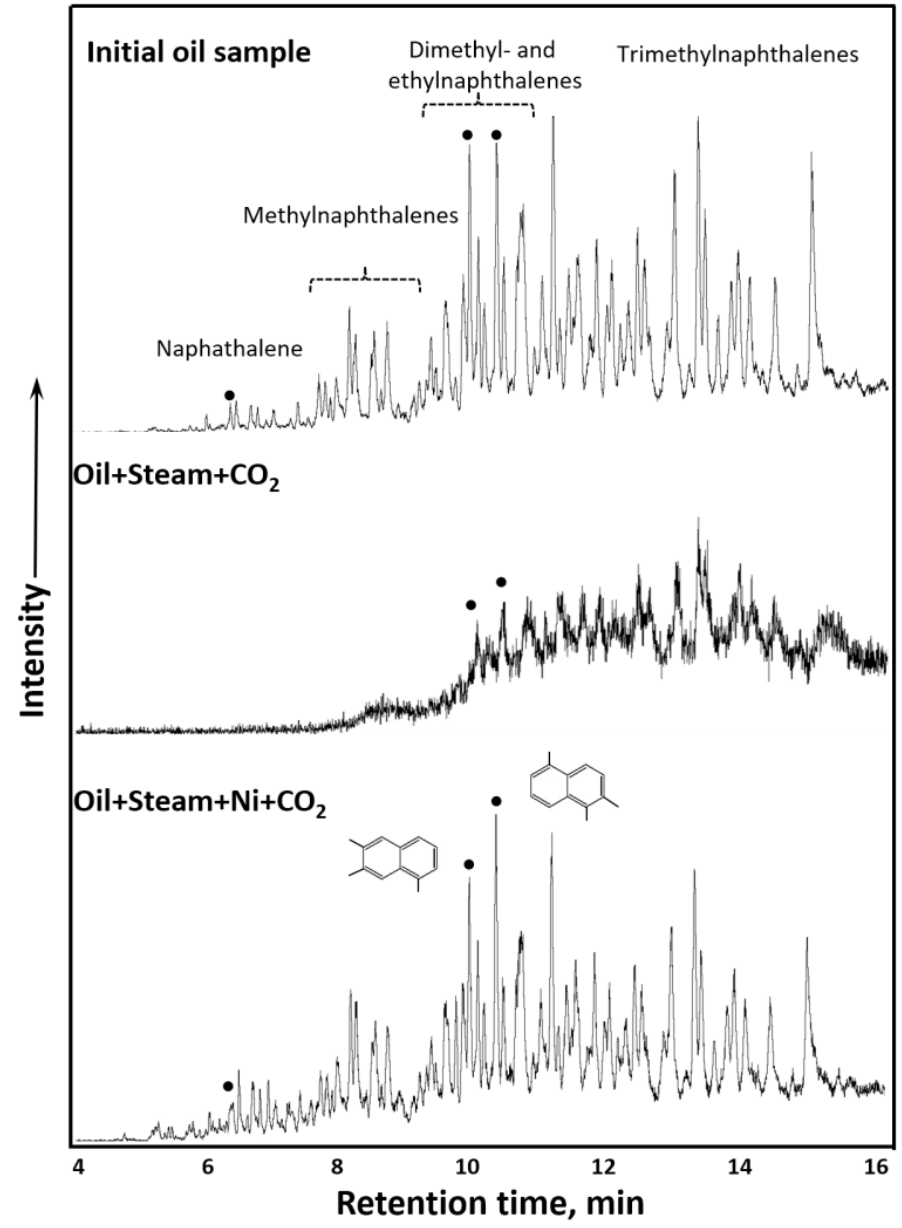
Figure 7. GC-MS spectra of naphthalene.